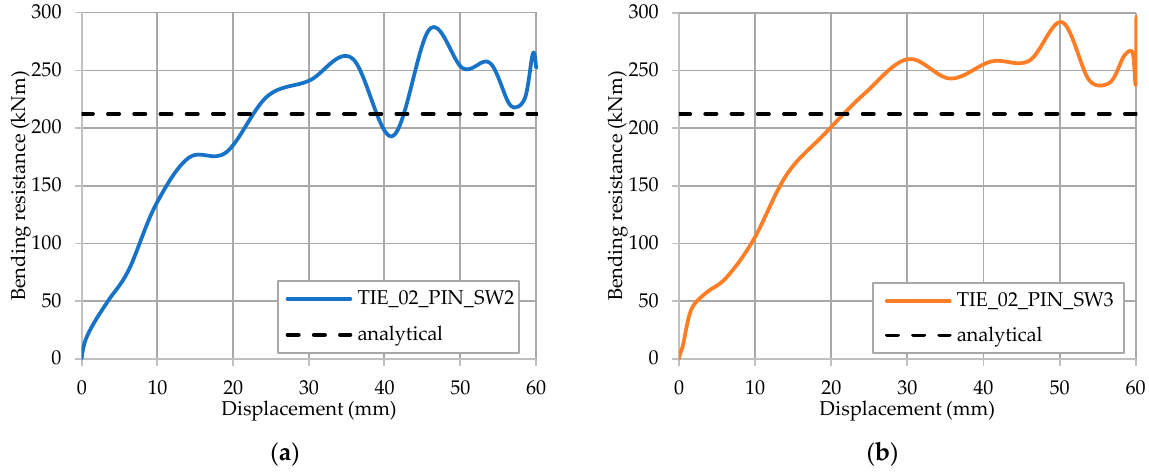
Figure 17. Bending resistance of the pinned beam for a fully tied shear connection: ( a ) SW2; ( b ) SW3.